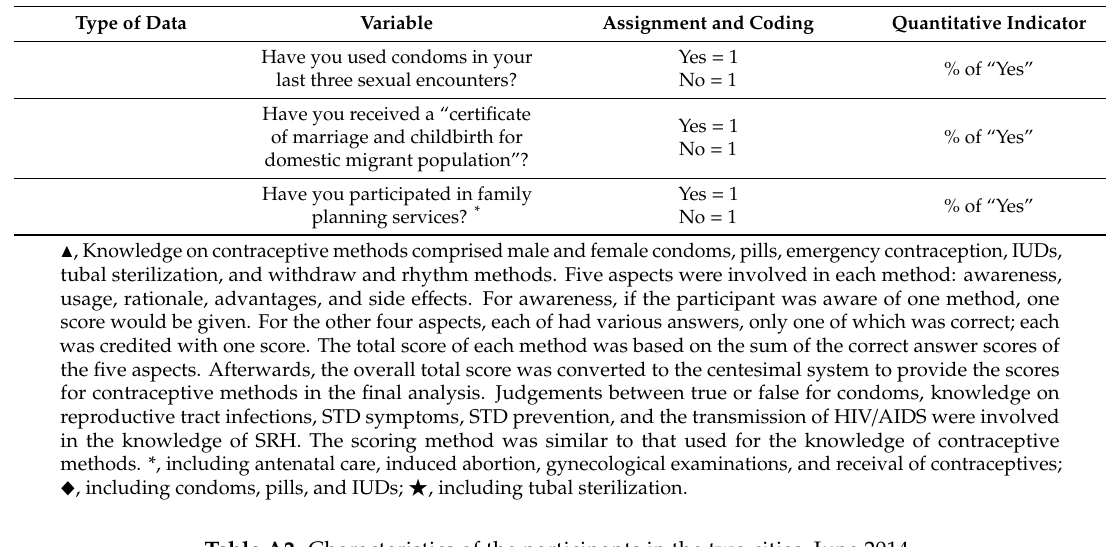
Table A2. Characteristics of the participants in the two cities, June